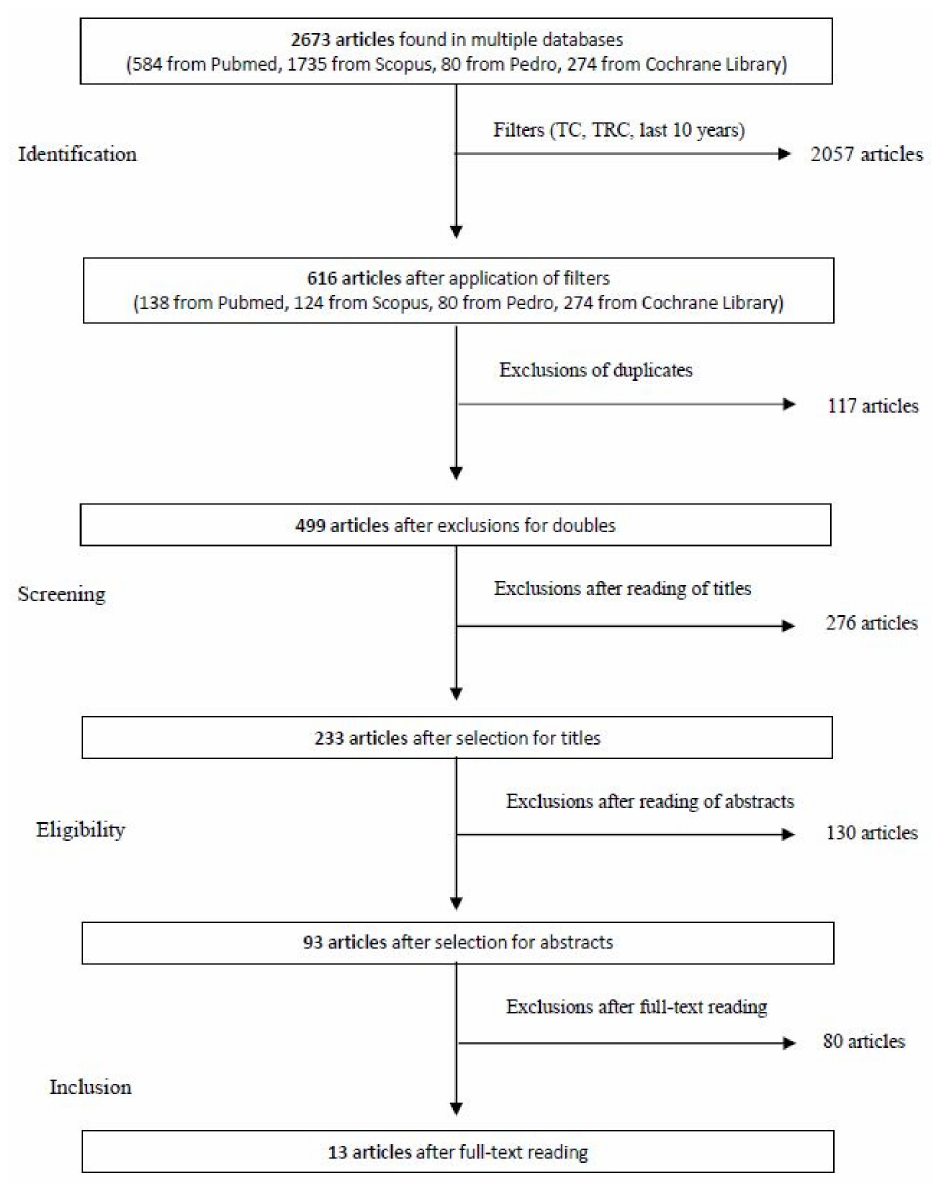
Figure 1. Flow chart of the study selection